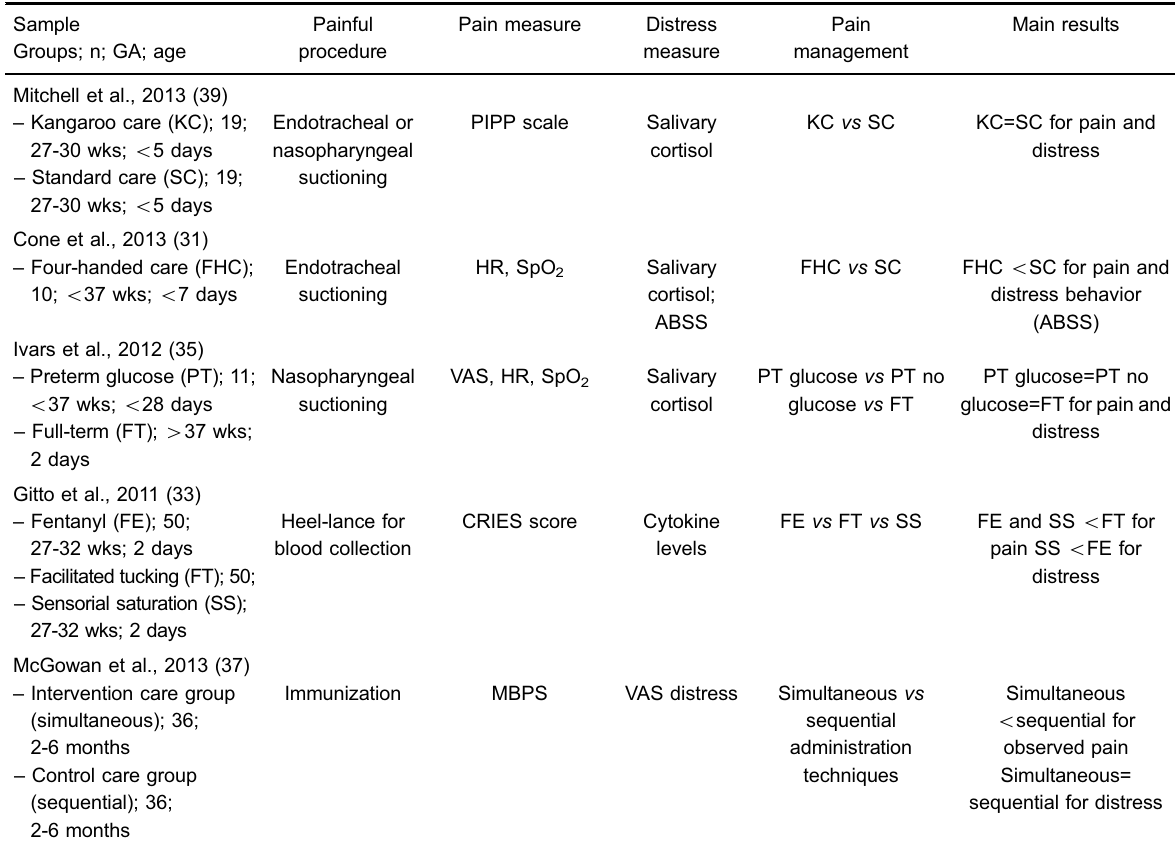
Table 2. Main fi ndings of randomized clinical trials that assessed pain and distress responses in infants (n=5).